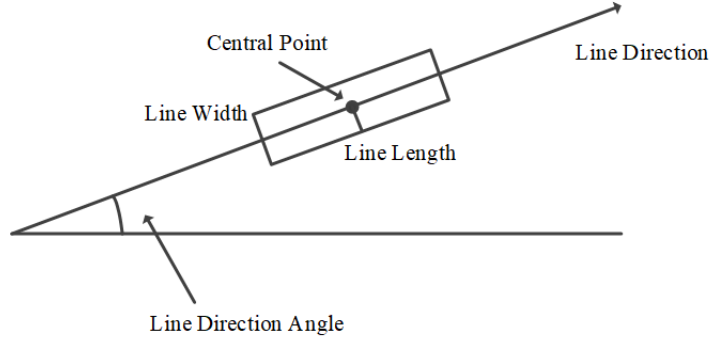
Figure 2. Rectangle estimation for a line segment from a candidate region. (3) Verify lines. It is necessary to verify lines to avoid false detections for as many as possible. The NFA (Number of False Alarms) is chosen as the verification indicator [16]. Consider an image of M × N pixels, it is defined as follows.